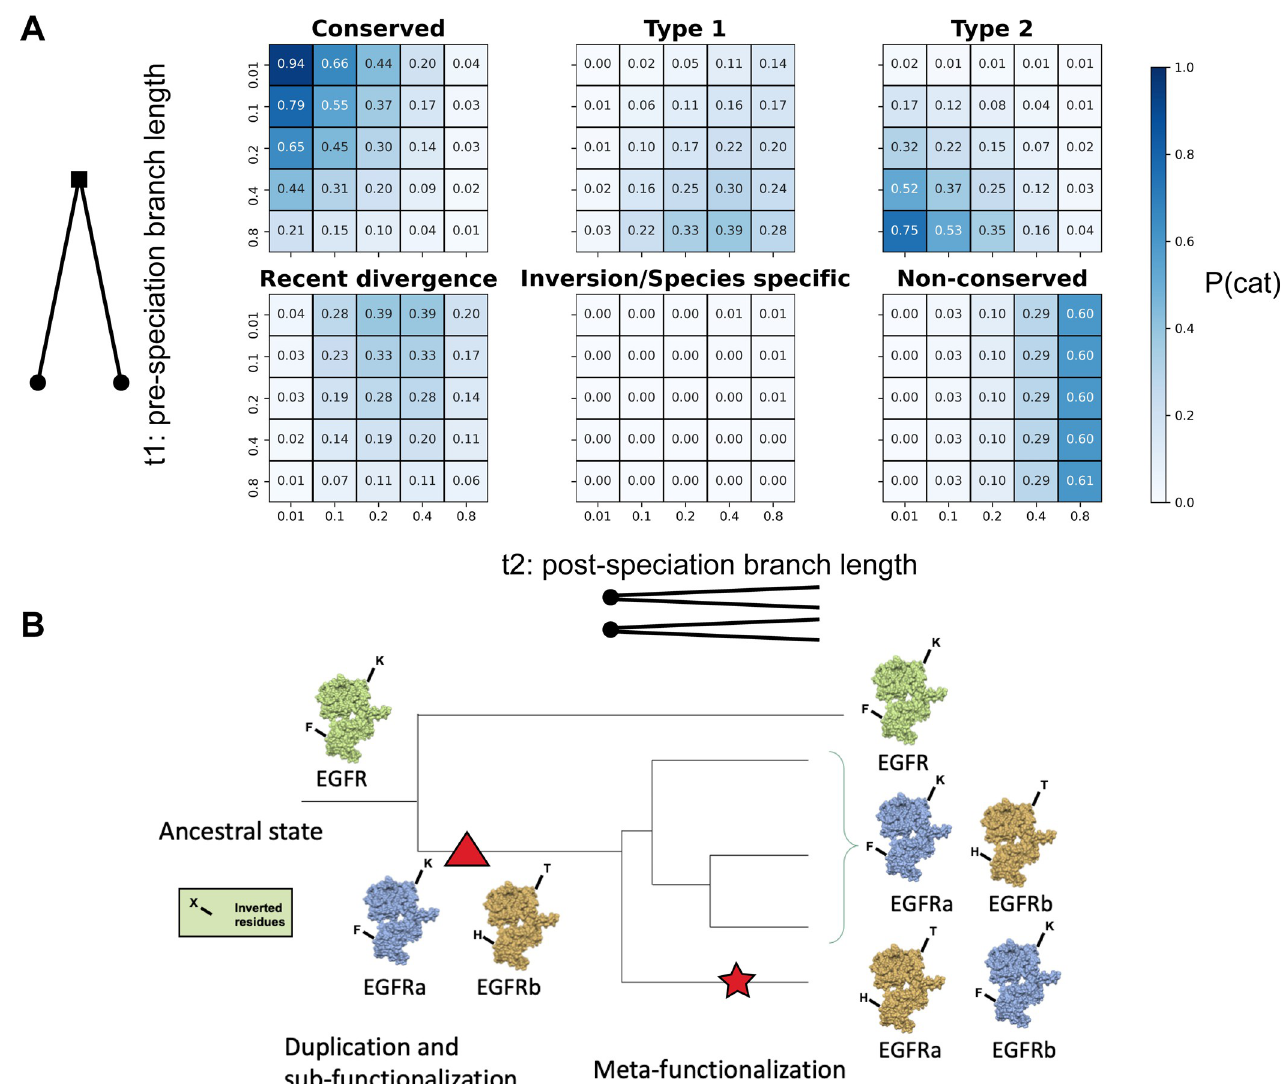
Fig 2. Theoretical model results. (A) The heatmaps show the category probabilities at different tree branch lengths as calculated using the theoretical model definitions. (B) Exemplification of “Meta-functionalization” (star), the putative driver of inter-paralog inversions in the phylogeny. A multifunctional protein (green) subdivides its functions (blue and yellow) between the two copies obtained after gene duplication (triangle). In a sub-group of species, the functional inheritance of the two copies is inverted. This event is revealed by the pattern of amino acids inversions compared to the majority of the other species.